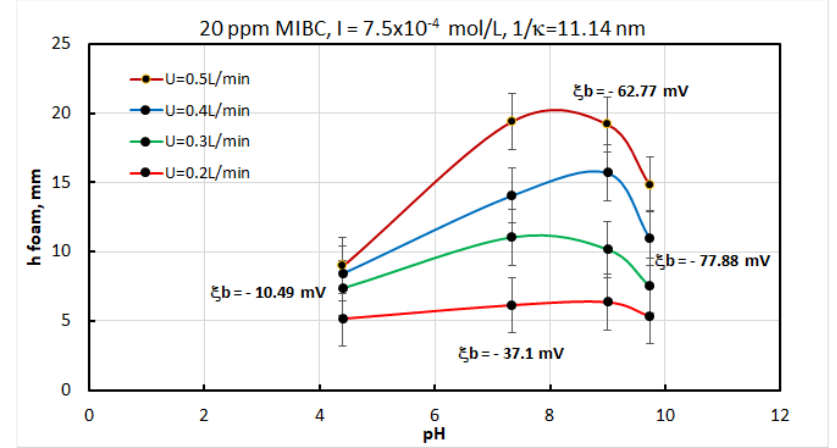
Figure 3. Height of the froth column of aqueous solution of 20 ppm MIBC vs. the pH value at constant ionic strength I = 7.5 × 10 − 4 mol/L at different gas delivery rates; the zeta potential of the bubbles at each pH value is depicted in the figure. The error bar is ± 2 mm. This behavior correlates with the DLVO theory [44,45,61].